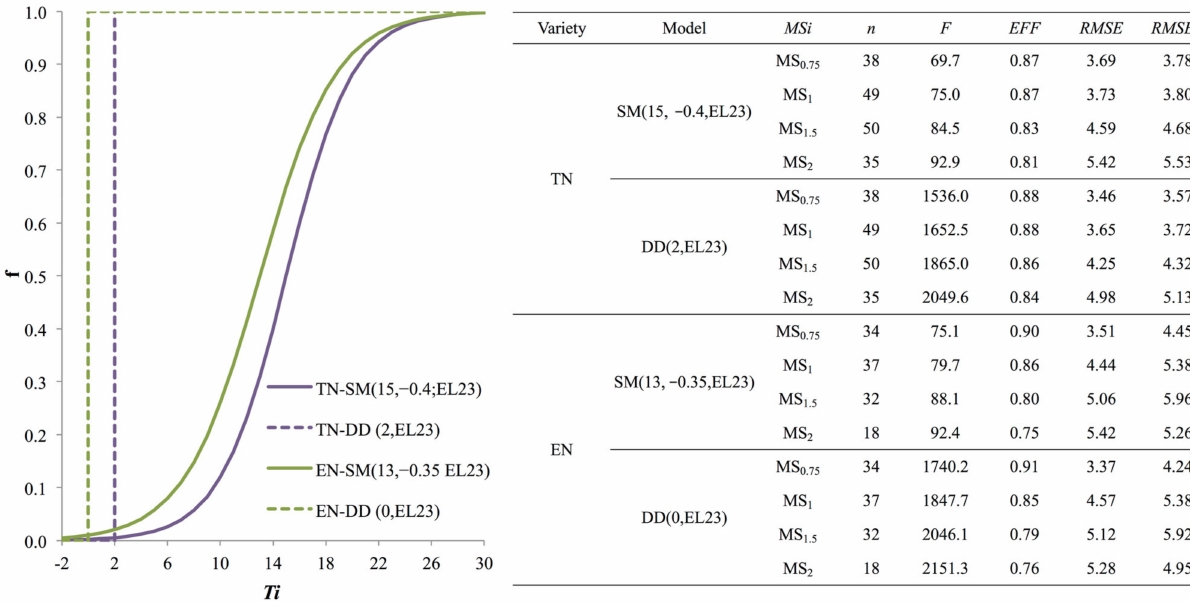
Figure 5. SM and DD models’ response functions for ripeness simulation of cv. Encruzado (EN) and Touriga Nacional ( TN ) in the D ã o wine Region. The efficiency coefficient ( EFF ), root-mean-squared-error ( RMSE ), and Root Mean Square Error of Prediction ( RMSEP ) for each maturity stage and variety are also depicted in the right-side